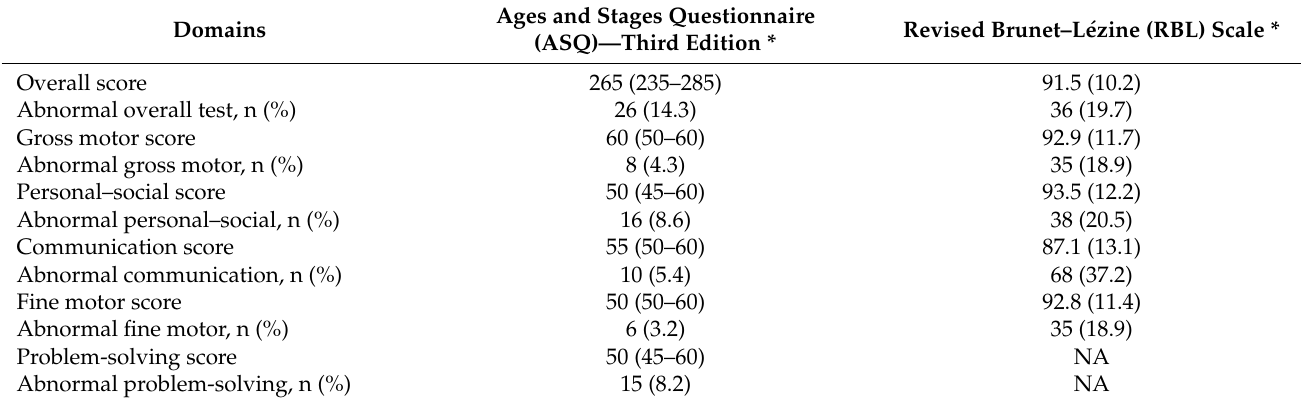
Table 2. Neurodevelopmental